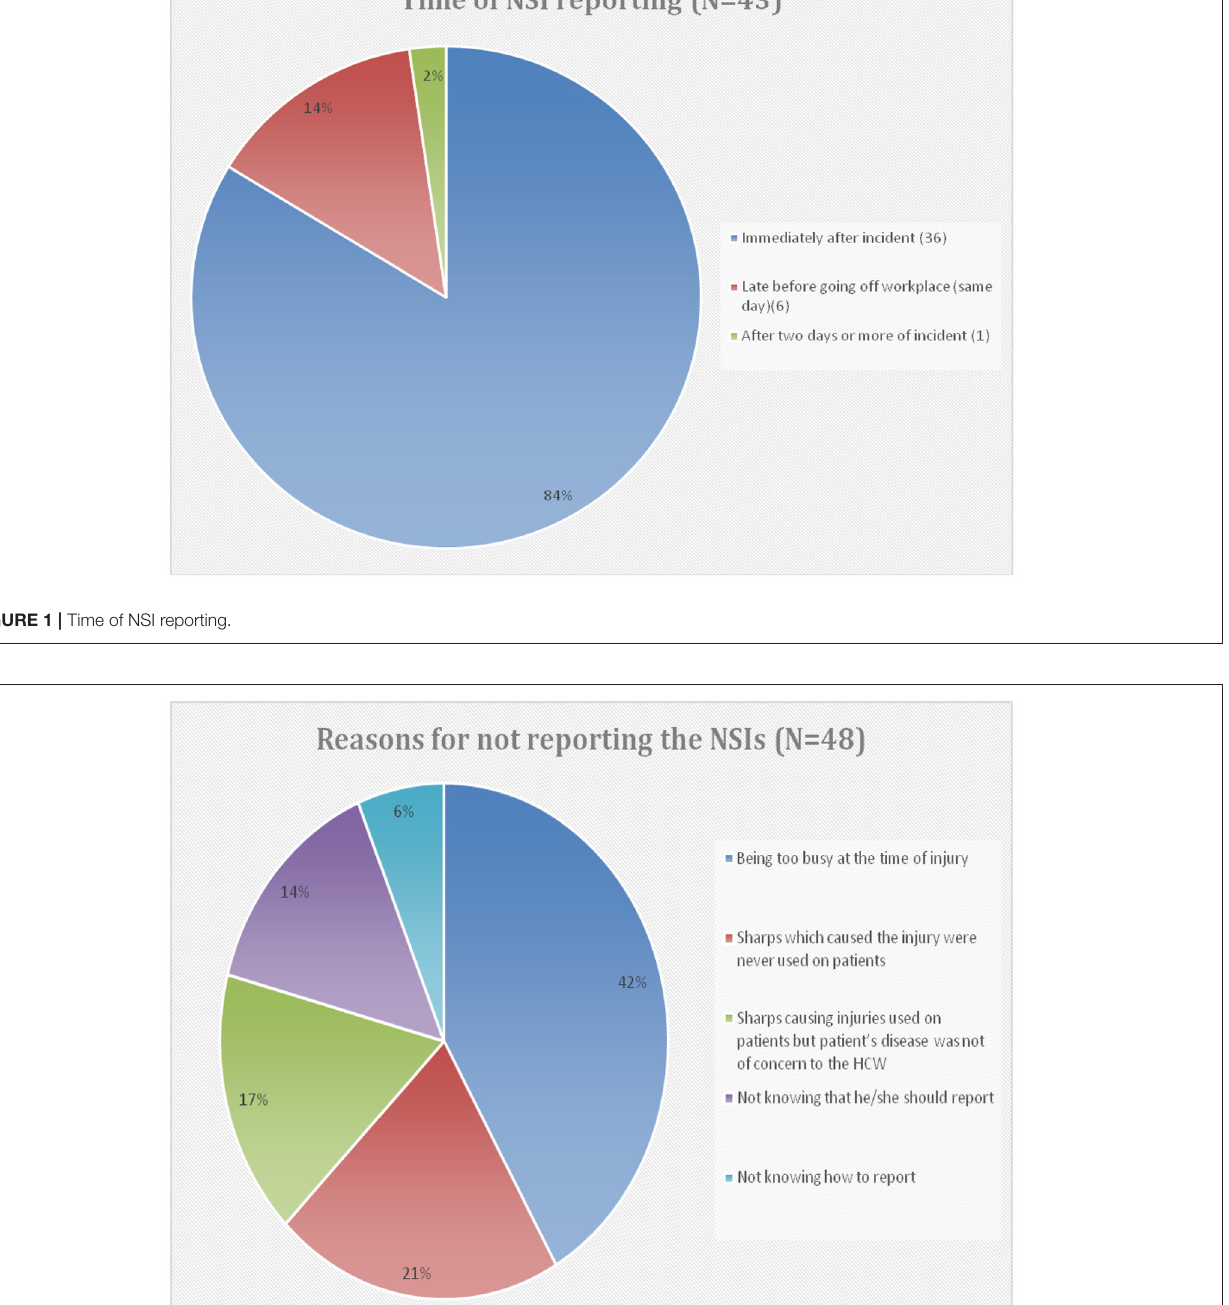
B vaccine, while 43.5% knew that there is no vaccine